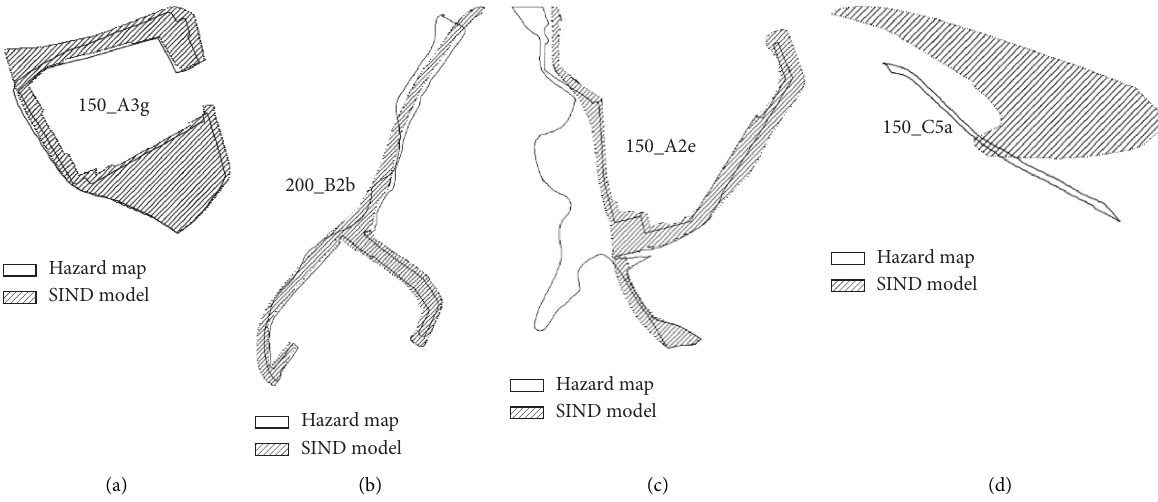
Figure 8: Examples of exact-matching and mismatching objects: (a) Exact 1; (b) Exact 2; (c) Mis 1; (d) Mis 2.